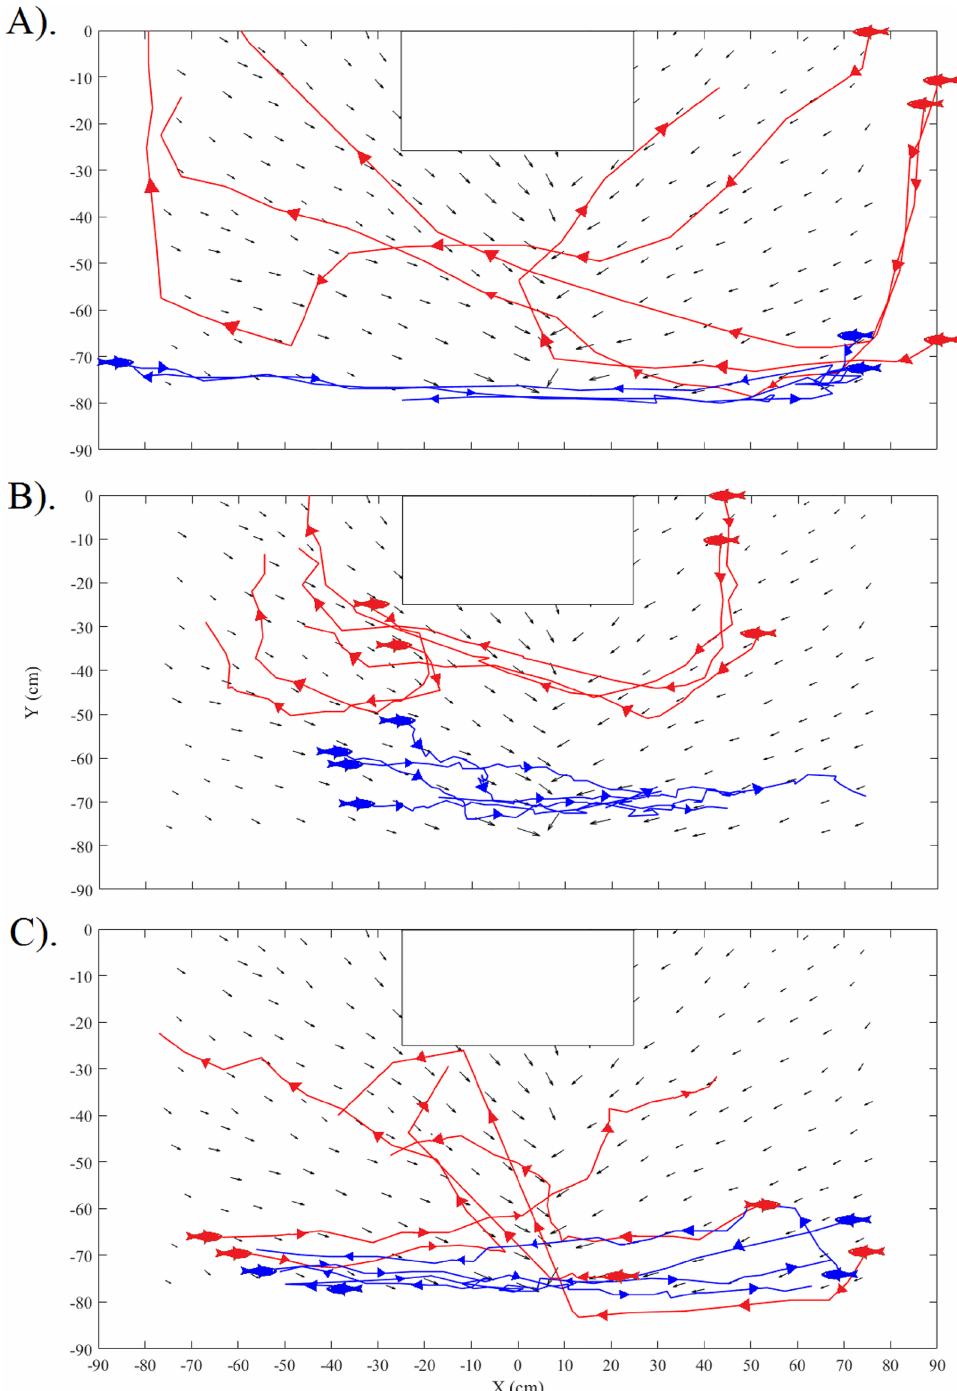
Fig 6. Representative responses of (A) common carp, (B) silver carp, and (C) bighead carp during control (blue lines) and treatment (red lines). Particle accelerationvectors are shownfor reference. A fish symbol denotes the start and arrows indicate direction of movement. Note trajectories follow a curvilinearpath parallelto local particle acceleration vectors duringtreatment periods, while trajectories follow paths parallelto the enclosurewall duringcontrol